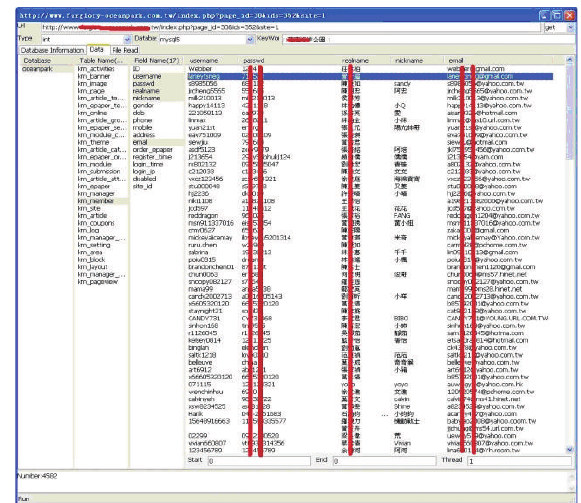
Figure14:Accountnamesandpasswordsofadatabase,storedusing plain